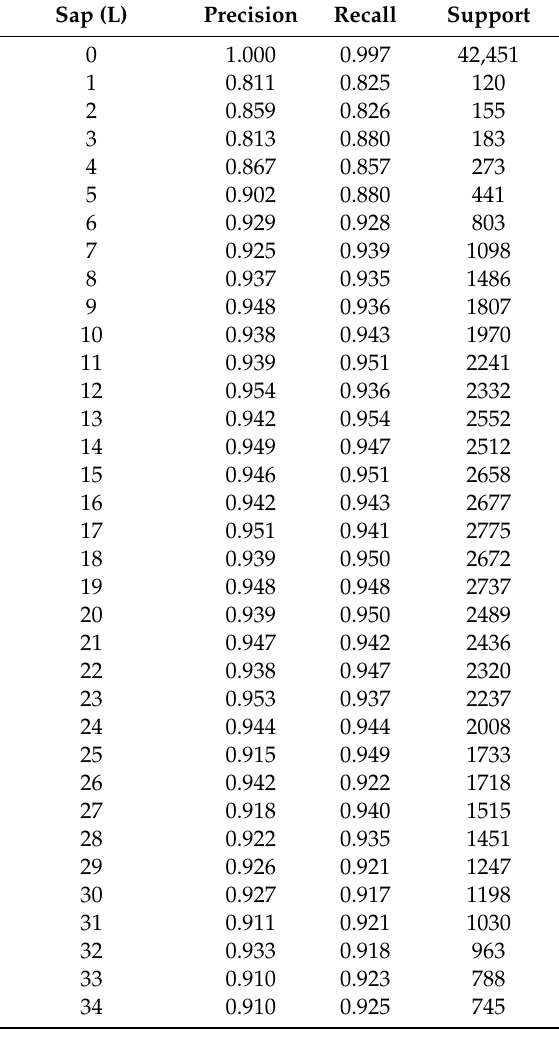
Table 11. Prediction accuracy of Random Forest optimal model. Sap (L) Precision